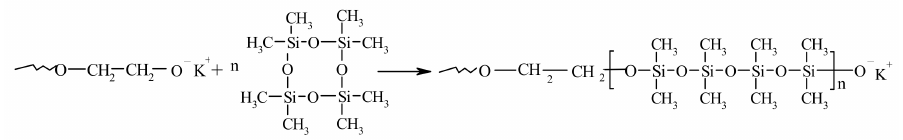
Scheme 3. Multi-block copolymer synthesis